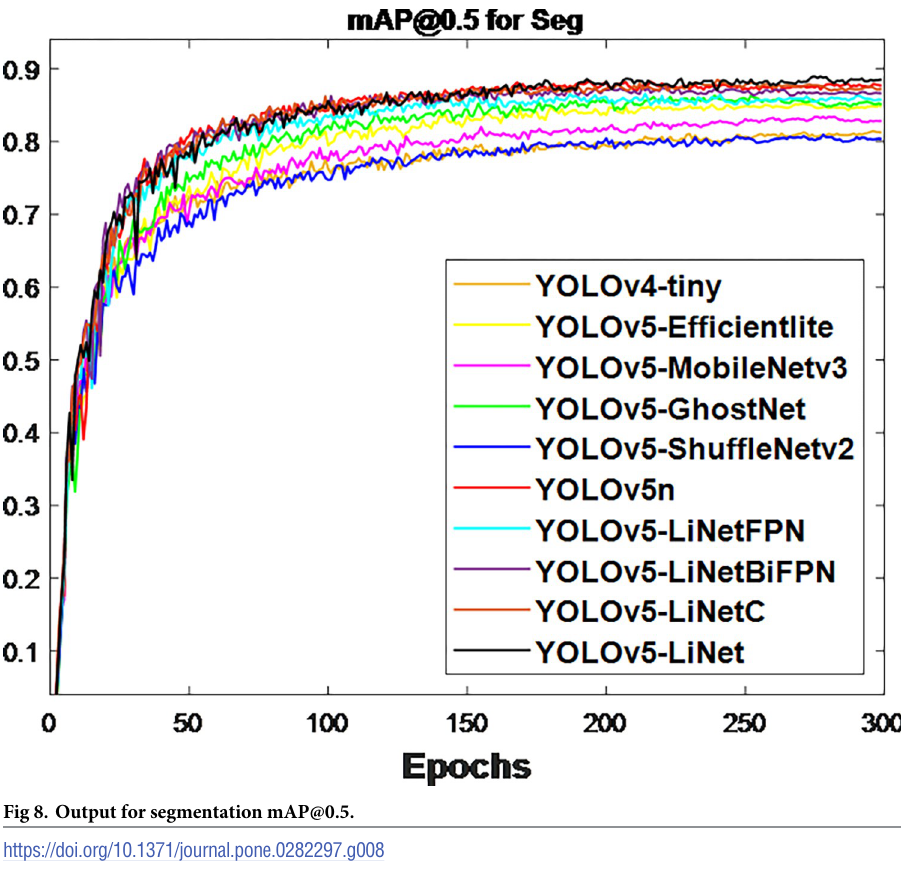
Fig 8. Output for segmentation mAP@0.5.